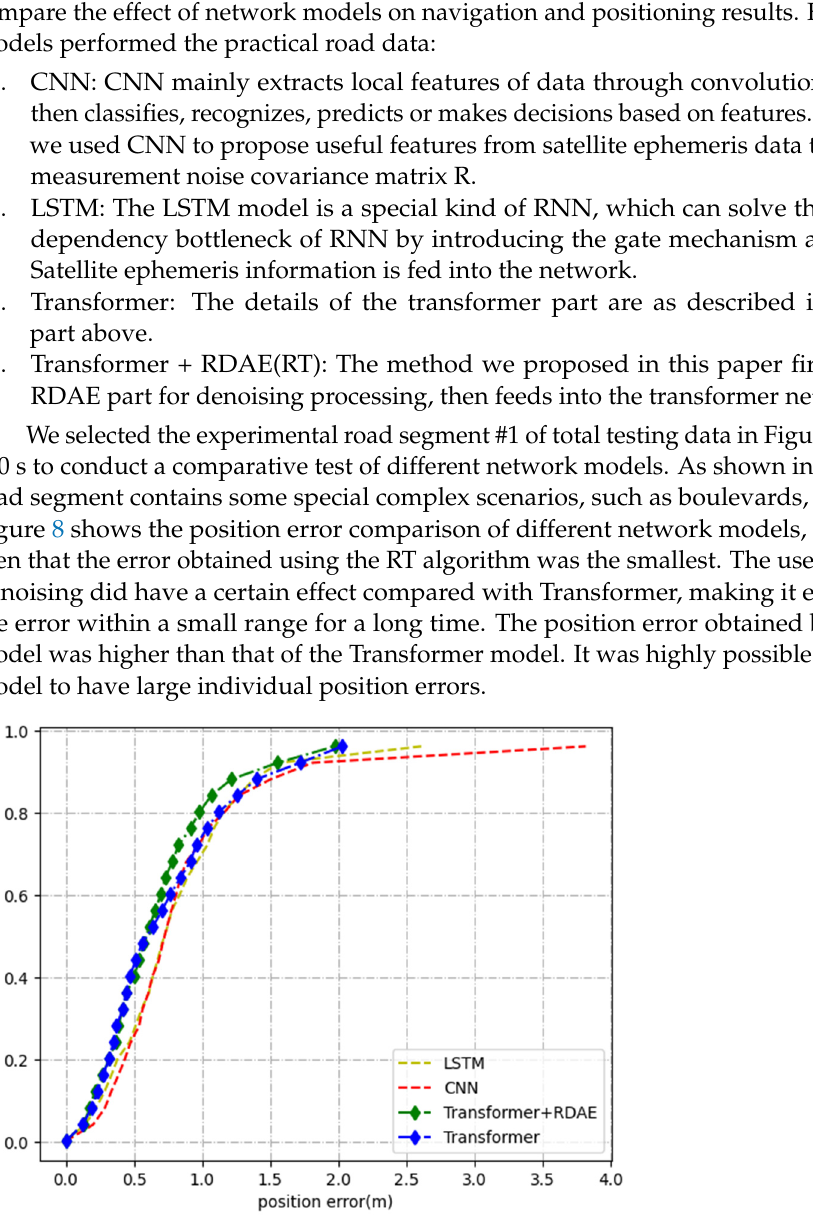
Figure 8. The position errors of GNSS/INS tightly coupled integrated navigation with R estimated by different neural networks.